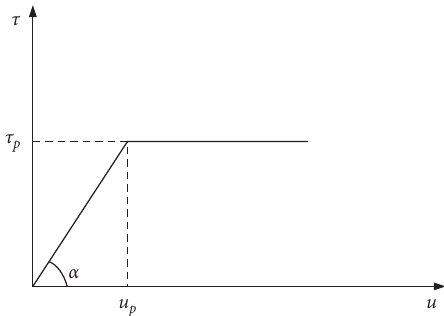
Figure 12: Relationship between the shear stress and the relative displacement of the soil nail.